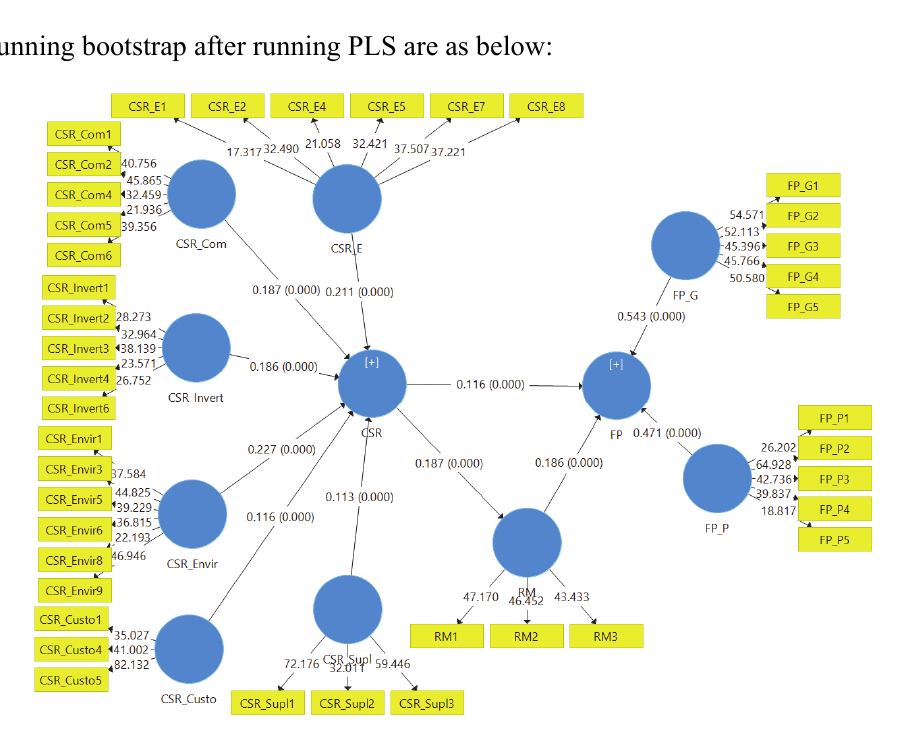
Fig. 2. Results of running